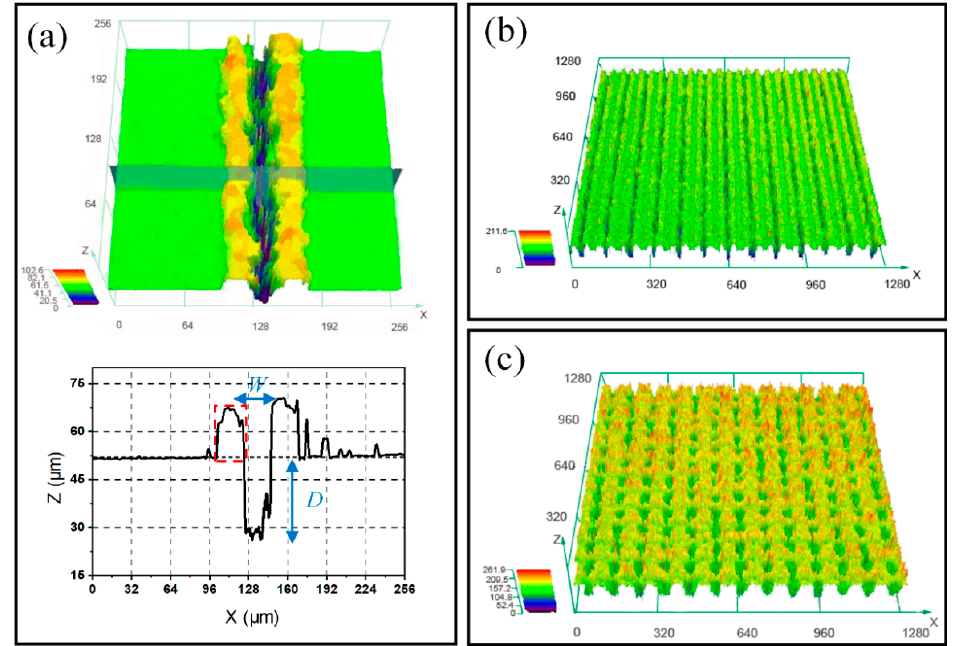
Figure 3. ( a ) 3D and cross-sectional profile of laser ablated single groove, 3D profile of the as-prepared surface: ( b ) line pattern, ( c ) grid-pattern.